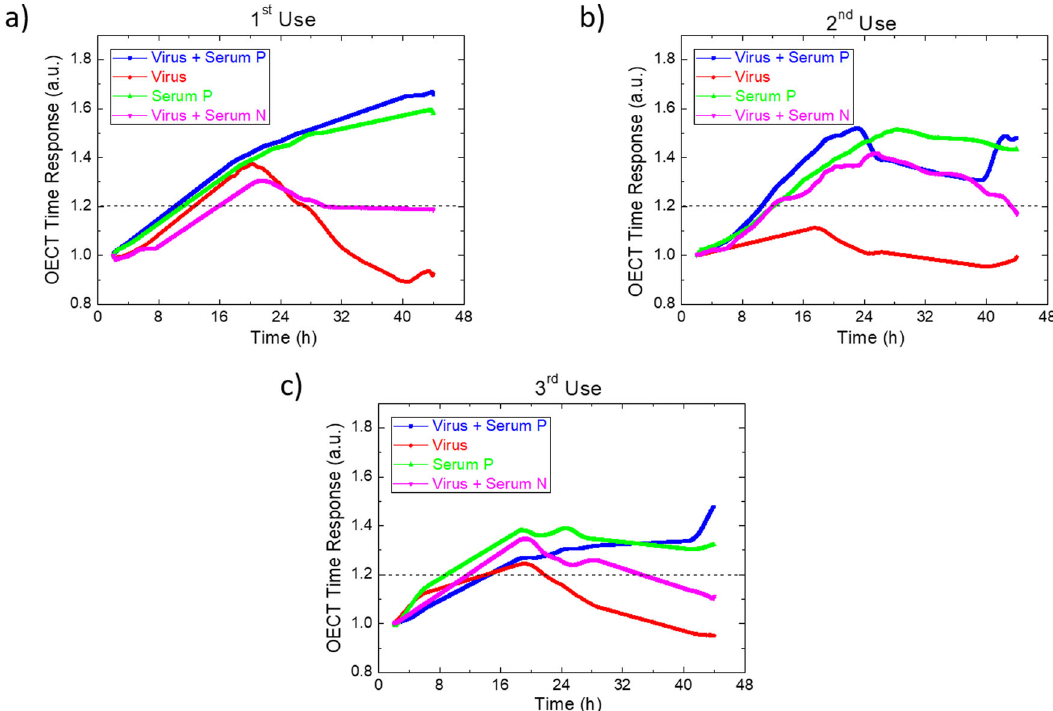
Fig. 5 OECT performances upon three repeated experiments. Device repeatability tests. OECTs have been employed up to three consecutive times (developing a cleaning procedure between the experiments) to monitor Sars-Cov-2-infected cell lines (red), with non-neutralizing (blue) and neutralizing (magenta) antibodies, together with neutralizing serum control (green). OECT fi rst, second, and third uses are reported in ( a ) – ( c ),